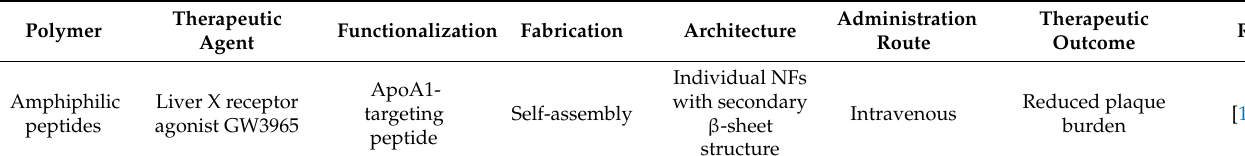
Table 2. Nanofiber systems used for delivery of small therapeutic